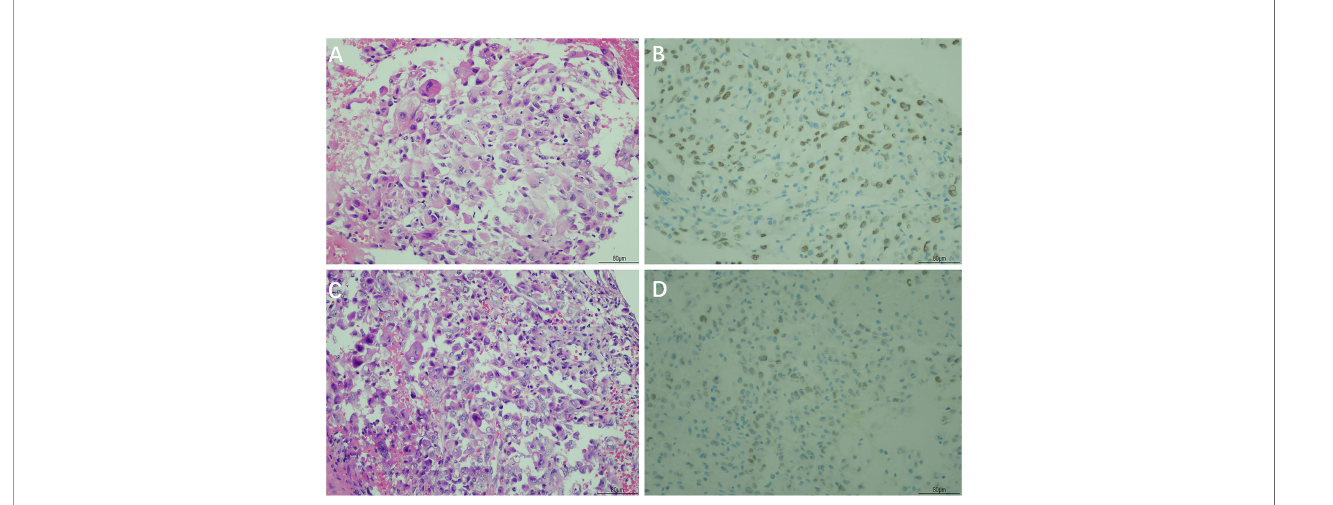
FIGURE 3 | Hematoxylin and eosin (H&E) and immunohistochemical staining of the primary lung cancer and gastric tumor biopsy. H&E staining showed poorly differentiated adenocarcinoma in the primary lung cancer tissue (A) and gastric tumor tissue (C) . Immunohistochemical staining showed a positive reaction for thyroid transcription factor-1 (TTF-1) in the primary lung cancer tissue (B) and gastric tumor tissue (D) (magni fi cation,